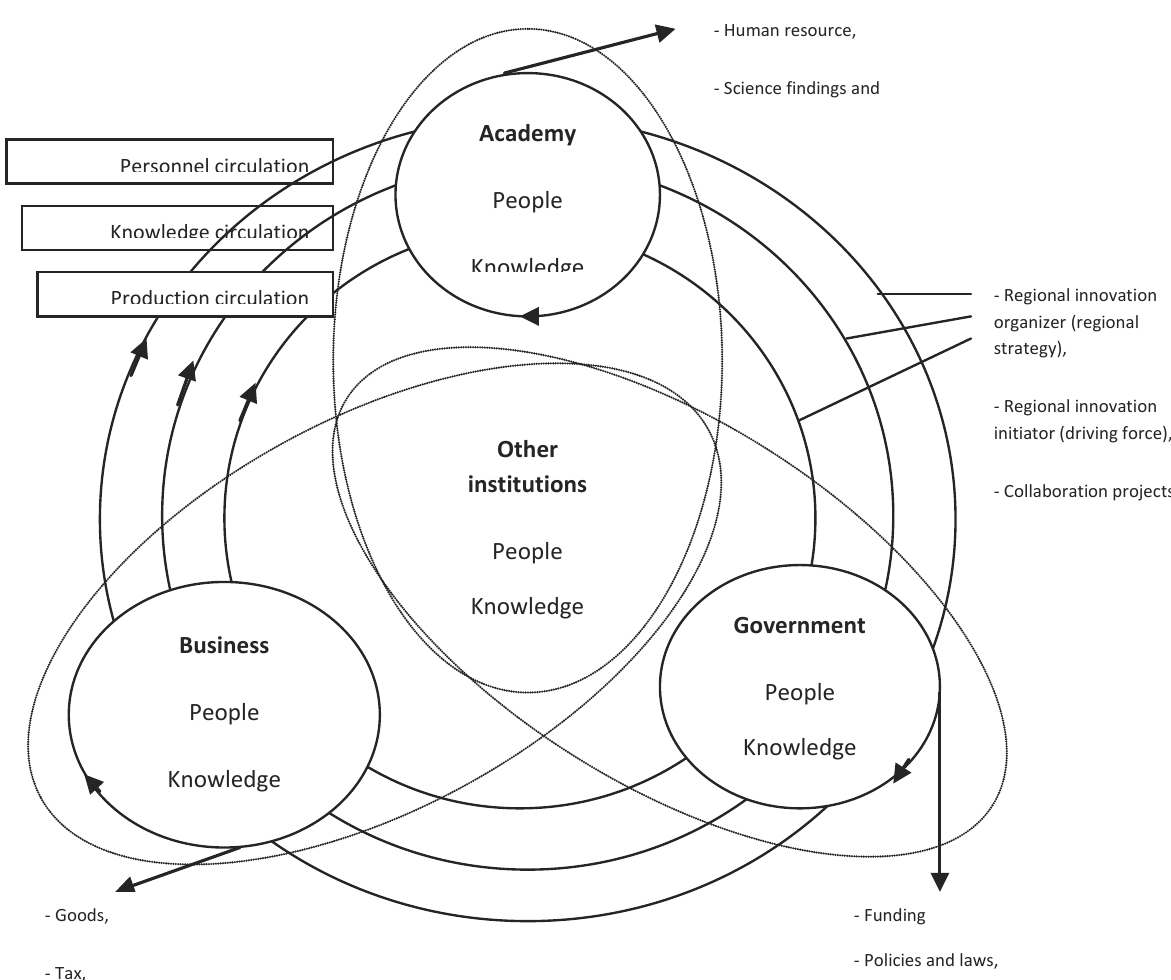
Fig 1. Triple Helix circulation at regional